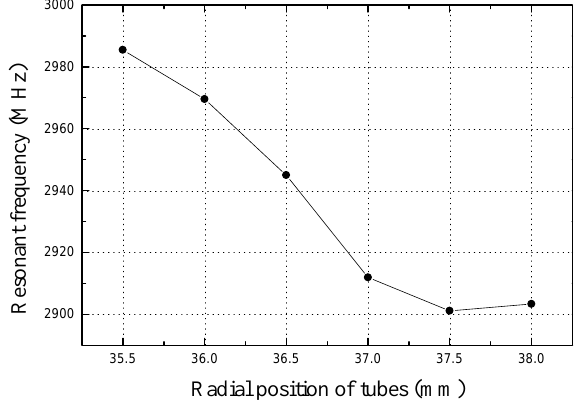
FIG. 2. Variation of resonant frequency as a function of the location of the support/cooling tubes in the PWT